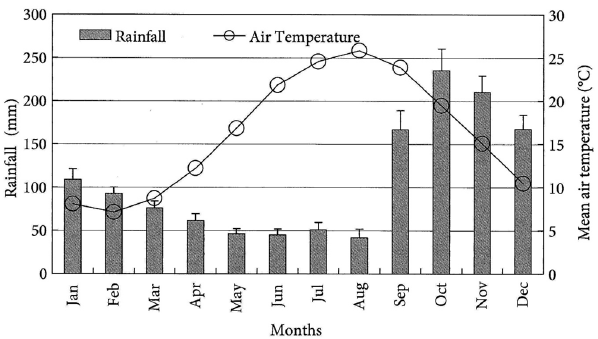
Fig. 1. Monthly mean rainfall and air temperature recorded dur- ing 23 years (1985-2008) by the Nowshahr synoptic weather station located in the airport. Error bars show the standard error of monthly rainfall during the recorded period (from Ahmadi et al ., 2009) Fig. 2. A microscopic section from a sample taken in the begin- ning of May. Phloem (Ph), developing tree ring (DR) and a part of previous tree ring (PR) have been labeled in the